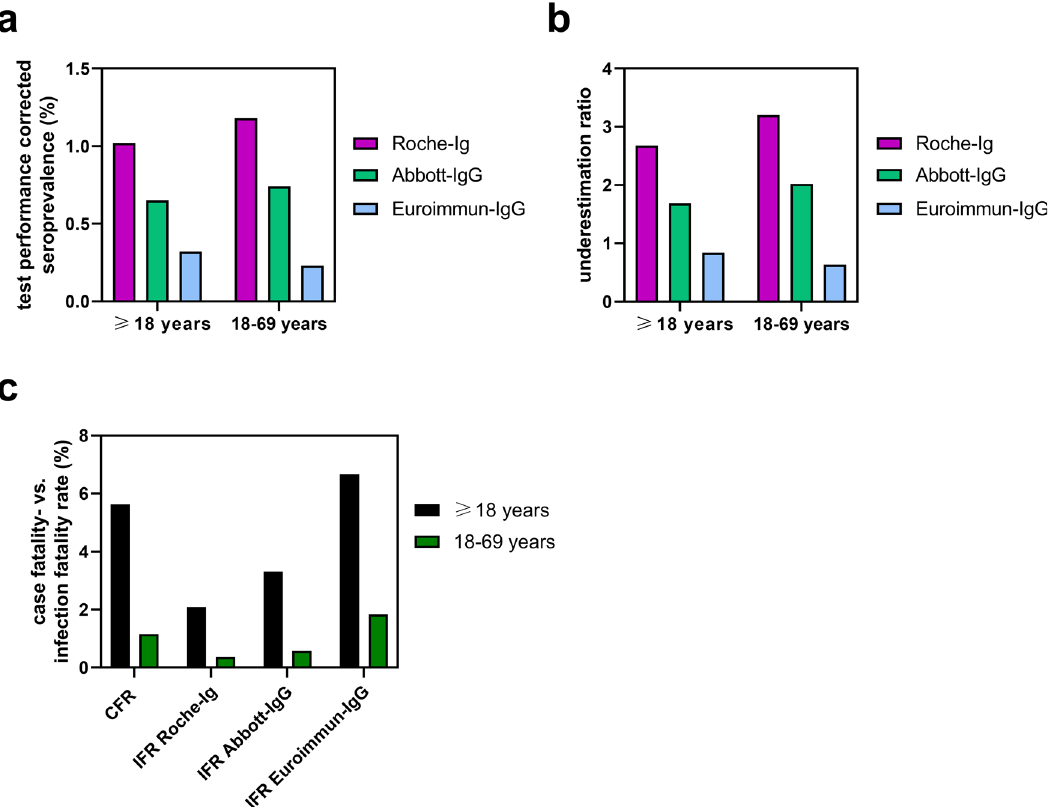
Fig. 6 Assay-dependent seroprevalence, underestimation ratio and estimation of IFR. a Test performance-corrected seroprevalence rates on October 15, 2020. b Underestimation ratio as calculated by corrected seroprevalence in relation to the number of reported PCR-positive cases in Saarland (valuation date October the 1st, 2020). c Infection fatality rates as calculated from the CFRs and respective underreporting rates on October 15, 2020, the end of the 1st pandemic wave. Data in the sub fi gures a – c were obtained with three different antibody tests systems, either in all adults or in adults younger than 70 years, respectively, as indicated. Respective 95% con fi dence intervals are shown in Supplementary Table